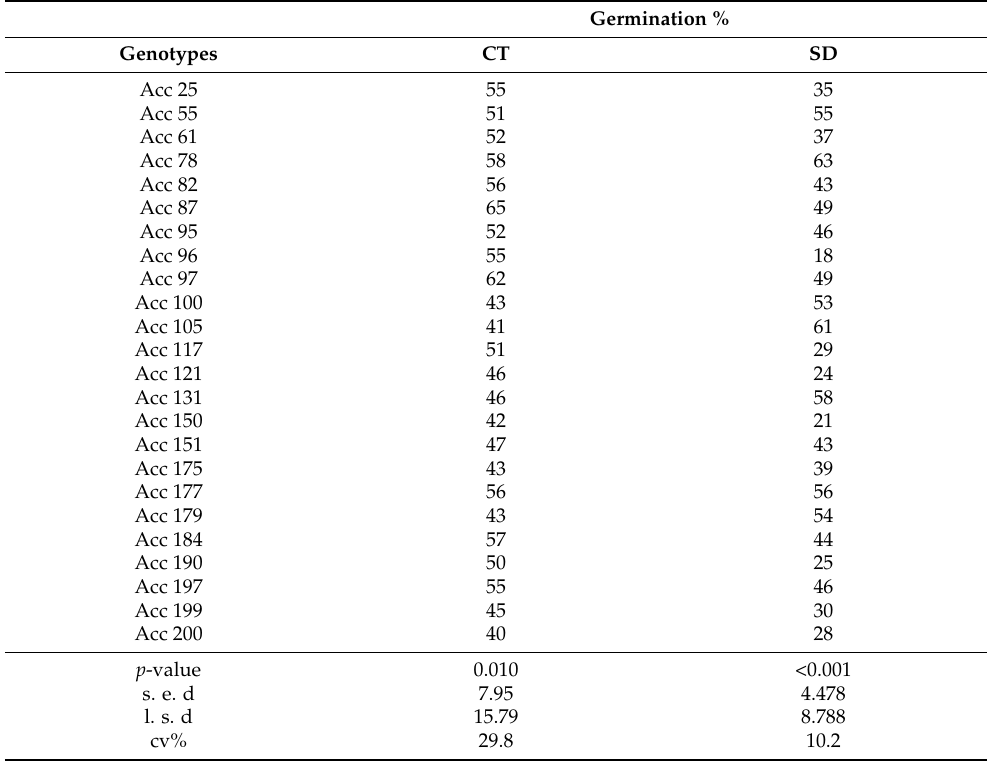
Table 3. The germination percentage among twenty-four (24) genotypes subjected to simulated drought conditions using 5% PEG compared to a control treatment using distilled